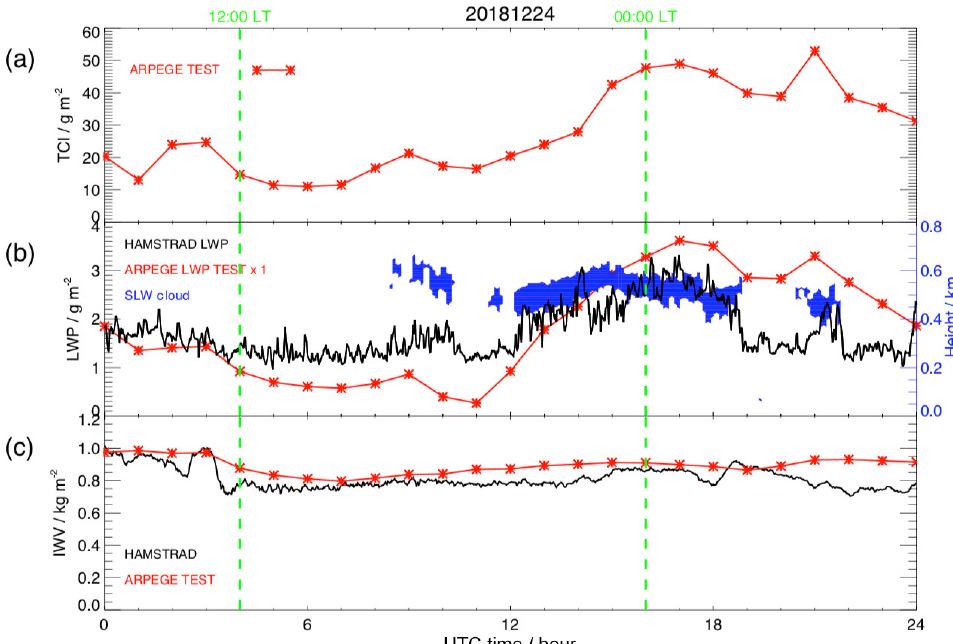
Figure 19. Diurnal variation on 24 December 2018 (UTC time) of (a) the total column of ice (TCI) (gm − 2 ) calculated by ARPEGE- SH in test mode (red crossed line), (b) the liquid water path (LWP) measured by HAMSTRAD (gm − 2 , black solid line) and calculated by ARPEGE-SH in test mode (– no scaling – gm − 2 , red crossed line), and (c) the integrated water vapour (IWV, kgm − 2 ) measured by HAMSTRAD (black solid line) and calculated by ARPEGE-SH in test mode (red crossed line). Superimposed on panel (b) is the SLW cloud thickness (blue area) deduced from the lidar observations (see Fig. 2c) (blue y axis on the right of the figure). Two vertical green dashed lines indicate 12:00 and 00:00LT.